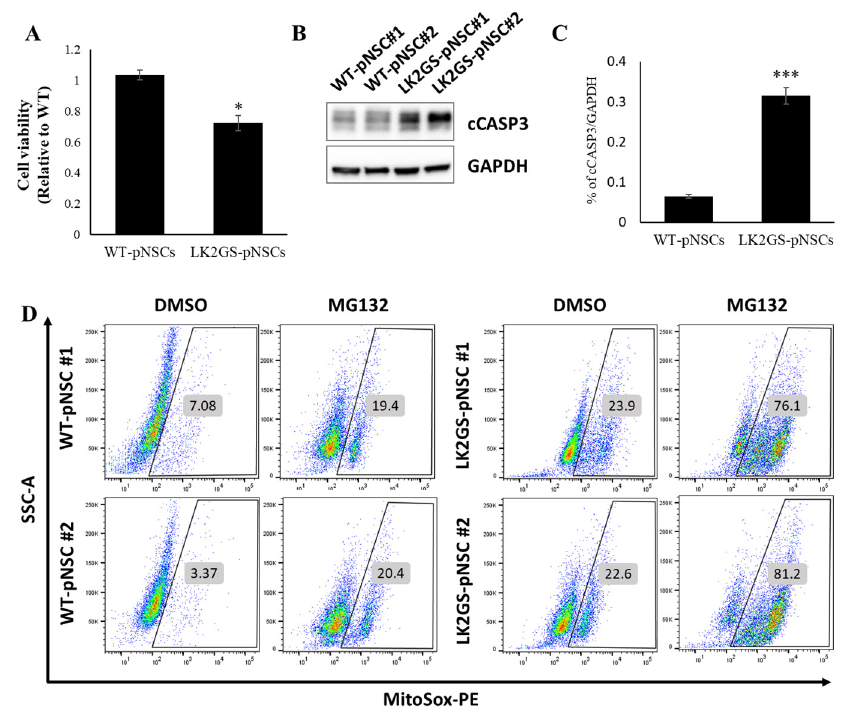
Figure 2. LK2GS pNSC as a PD model. ( A ) Cell viability assay with MG132 treatment. p -values were analyzed using the unpaired two-tailed Student’s t -test (* p < 0.05). ( B ) Representative Western blot for cleaved caspase-3 (cCASP3) in WT- and LK2GS-pNSCs. GAPDH was used as an internal control. ( C ) Quantification of cCASP3 after normalization using GAPDH. p -values were analyzed using the unpaired two-tailed Student’s t -test (*** p < 0.001). ( D ) Mitochondrial reactive oxygen